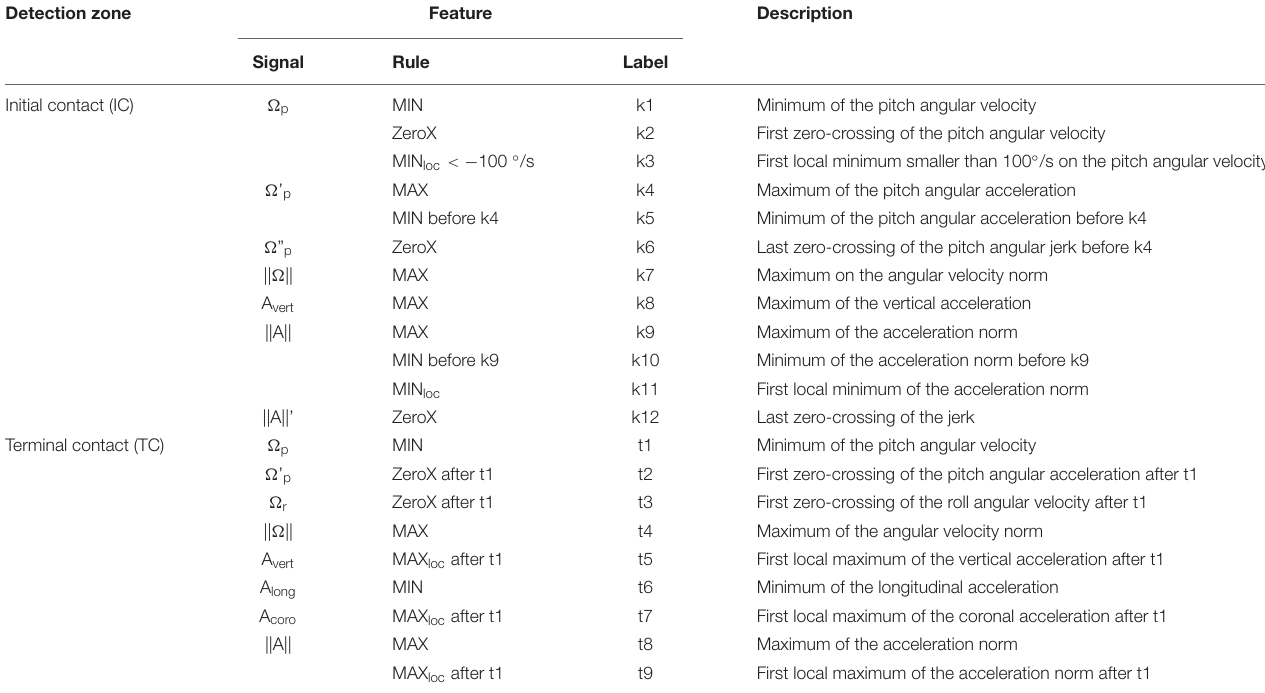
TABLE 1 | Summary of the features used on the inertial sensors signals to detect initial contact (Ic) and terminal contact (Tc). Detection zone